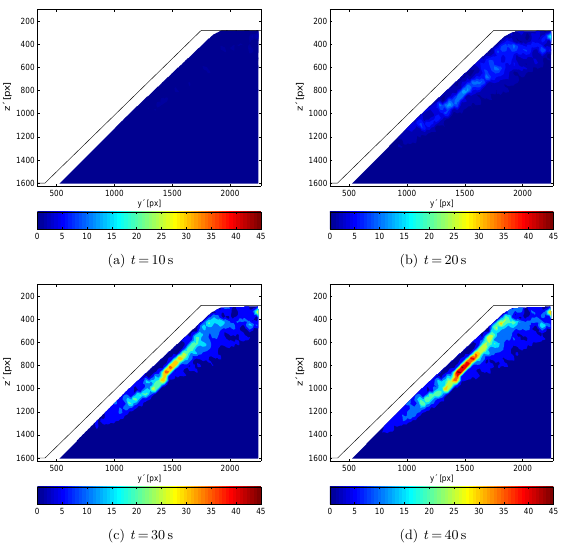
Figure 6.15: Development of shear strain of test CRF-03. The solid black lines represent the shape of Figure 7. Snap shots of shear strain for the rainfall the slope prior rainfall initiation. duration of t = 10 , 20 , 30 , 40 s drop as the wetting front descends. In addition, the cohesive and frictional components of the soil strength increase with depth. In comparison to the slope failure observed upon increasing self-weight (Chapter 5), the volume of the initial slide of the Type A failure mode is smaller due to the reduced depth of the slip surface. The evolution of the shear zone is visualised in Figure 6.15. The highest shear strain in evident at the mid-height of the slope. Similar observations are made on self-weight induced slope failures. In the figures on cumulative soil displacements (Fig. 6.14) and shear strain (Fig. 6.15) the mobilised soil mass seems to follow a straight plane inclined at about 33degree, arising in the figures of 20s rainfall duration. Yet, under continuous rainfall the shear zone develops under a steeper angle of about 55degree in the upper half of the slope towards the crest region. Based on the presented pre-failure deformation with maximum values in the top region, the rain-induced slope failure